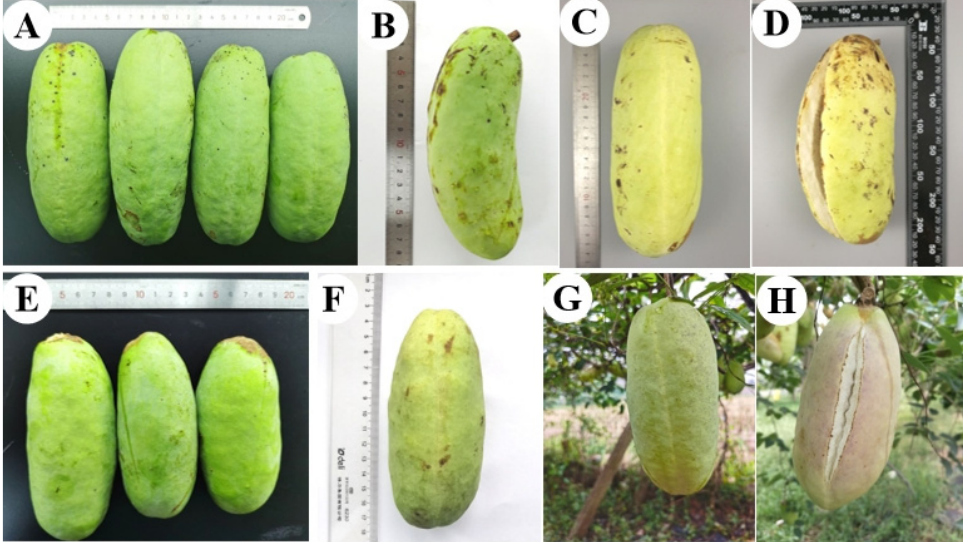
Figure 1. The fruits of A. trifoliata at different maturity stages. ( A – D ) the fruit of Luqing at S1, S2, S3, and S4 stages, respectively. The pericarp is pale green when it cracks. ( E – H ) the fruit of Luyu at S1, S2, S3, and S4 stages, respectively. The pericarp is light pink when it cracks. S1: 120 days after full bloom (DAFB), S2: 134 DAFB, S3: 148 DAFB, S4: 155 DAFB.